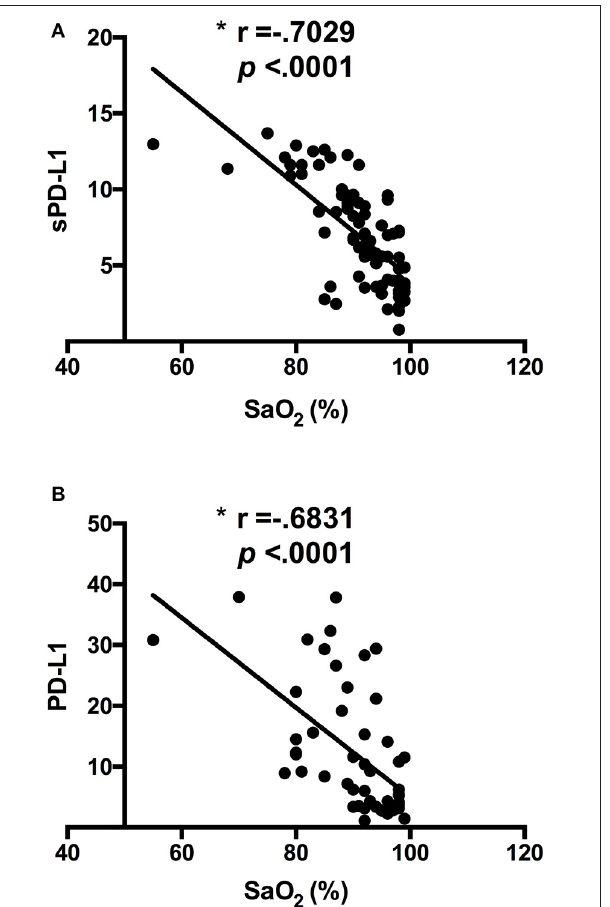
FIGURE 4 | PD-L1 and sPD-L1 levels are increased in patients with low oxygen saturation. (A) Blood samples from patients with sepsis ( n = 85) and healthy volunteers (HV, n = 15) were stained with anti-PD-L1 antibody. Next, percentages of PD-L1 + cells were analyzed on the gate of CD14 + cells by FACS. Percentages of CD14 + PD-L1 + cells in patients classified according to their oxygen saturation are shown. (B) Concentrations of sPD-L1 were quantified in sera from septic patients and HV by ELISA. * p < 0.05 using a Student’s t -test.